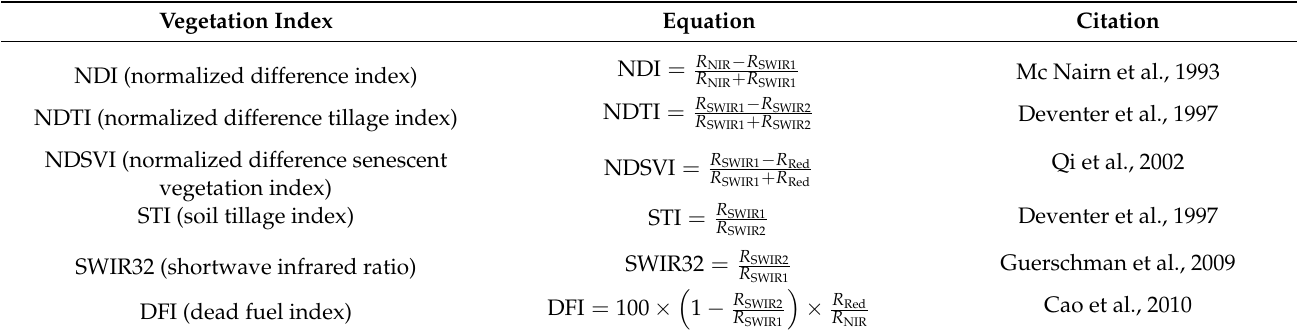
Table 2. The Sentinel-2-based multispectral non-photosynthetic vegetation indices (NPVIs) used for the non-photosynthetic vegetation ( f NPV )